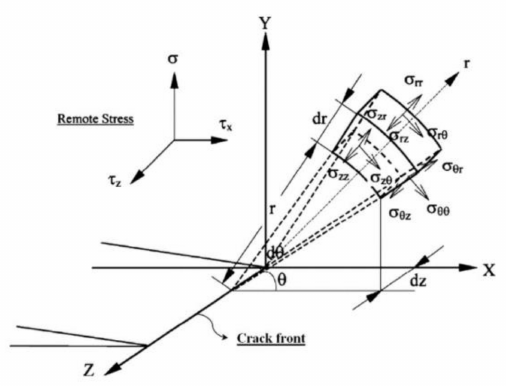
Figure 13. Mixed-mode I/II/III stress fields near the crack tip